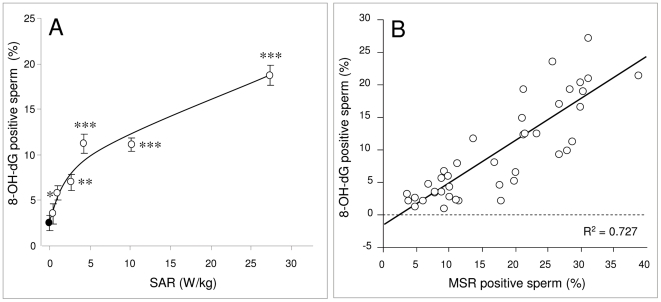
RF-EMR induces oxidative DNA damage in human spermatozoa.Following Percoll fractionation, 5×106 high density, spermatozoa were suspended in 1 ml BWW. The cells were placed in 35 mm Petri dishes and placed inside a waveguide. 5×106 cells in 1 ml BWW were placed outside the waveguide as a control (closed circle). The cells in the waveguide were exposed to 1.8 GHz RF-EMR at SAR levels between 0.4 and 27.5 W/kg (open circles) and all samples were incubated for 16 h at 21°C. Following incubation, Fe2+ and H2O2 was added to cells to act as a positive control, incubated for 1 h, then 100 µl 2 mM DTT/BWW solution was added and incubated for 45 min at 37°C. Cells were fixed and labeled with 100 µl charcoal purified anti-8-OH-dG, FITC tagged antibody at a dilution of 1∶50, incubated at 21°C for 1 h, washed and then assessed by flow cytometry. A, As the power levels were increased, the amount of oxidative DNA damage expressed also increased. A significant amount of oxidative DNA damage was observed in cells exposed to 2.8 W/kg (*p<0.05) RF-EMR and above (**p<0.01; ***p<0.001). Results are based on 4 independent samples. B, The levels of 8-OH-dG expression were positively correlated with the levels of ROS generation by the mitochondria (R2 = 0.727).